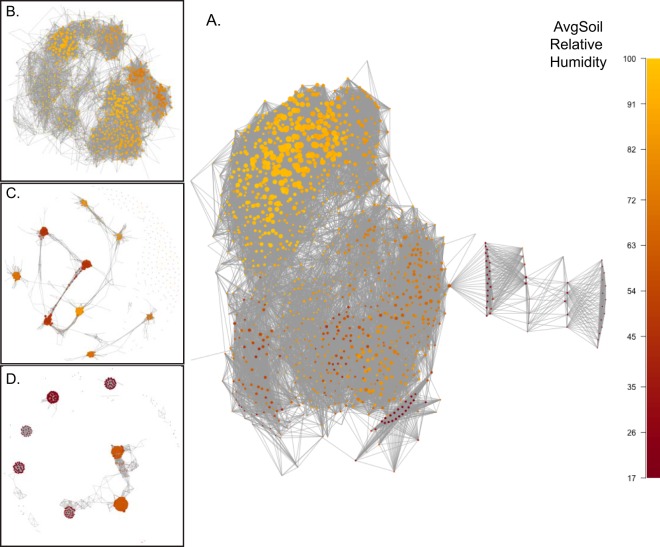
Network topology plots of Atacama microbial communities. (A) Full Atacama desert network. (B) Arid subnetwork. (C) Margin subnetwork. (D) Hyperarid subnetwork. Node colors represent average levels of soil relative humidity of the site or sites where the OTU is located, and the relative node sizes indicate the degrees of the node OTU. Subnetworks were created individually.